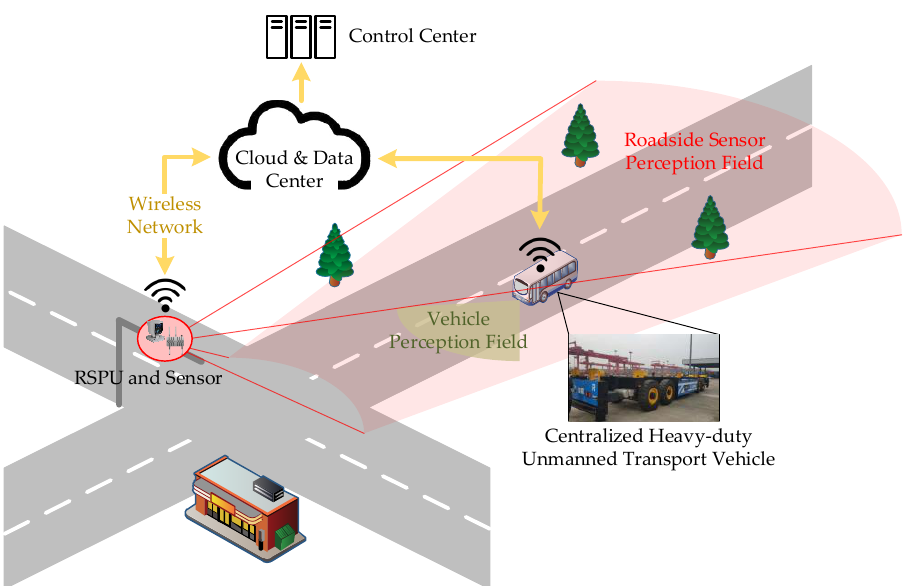
Figure 1. Vehicle pose estimation based on the roadside perception unit (RSPU) in a cooperative perception scene.